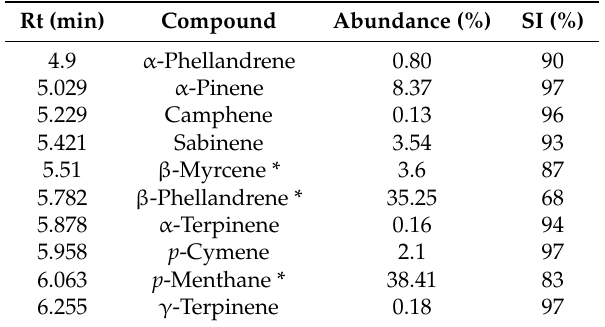
Table 1. Chemical composition of Bursera morelensis’ essential oil